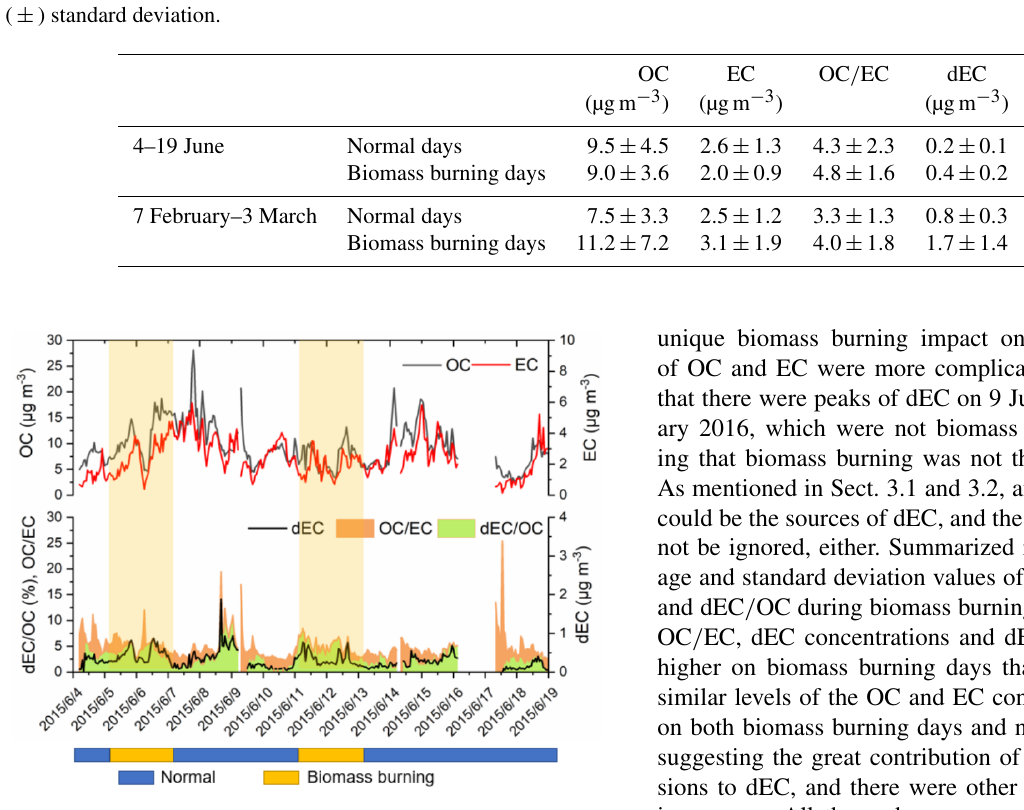
Figure 10. Time series of OC, EC, dEC / OC, dEC and OC / EC from 4 to 19 June 2015. The period was divided into normal days (blue bars) and biomass burning days (yellow bars). The yellow shading represents the biomass burning